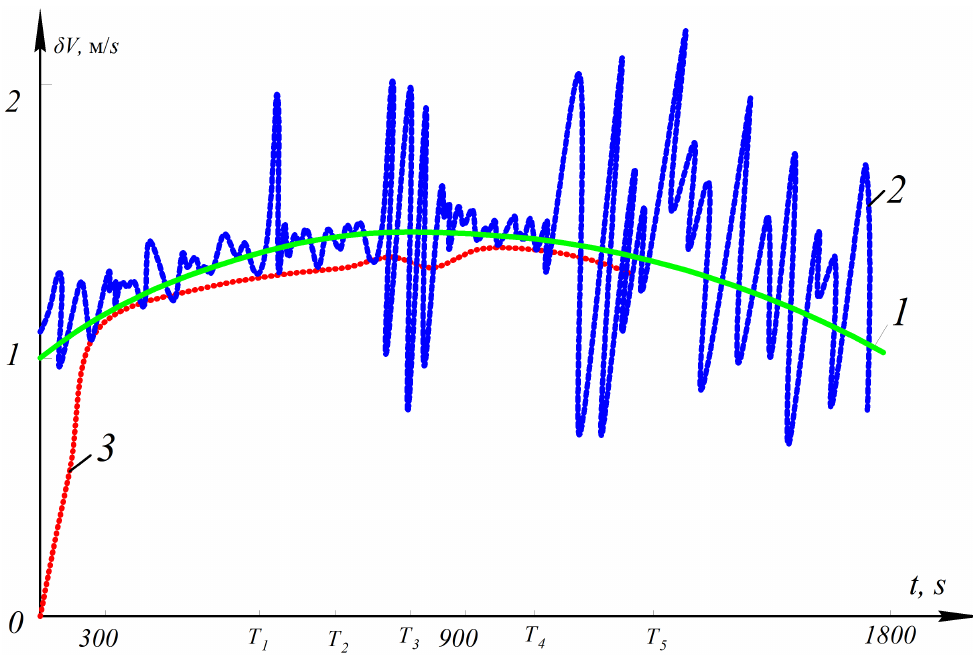
Figure 3. SINS errors in determining the speed and its estimation obtained by the proposed AKF: 1—SINS error in determining the speed; 2—measurements z, which are a mixture of SINS and GNSS errors; 3—SINS error estimation using the proposed